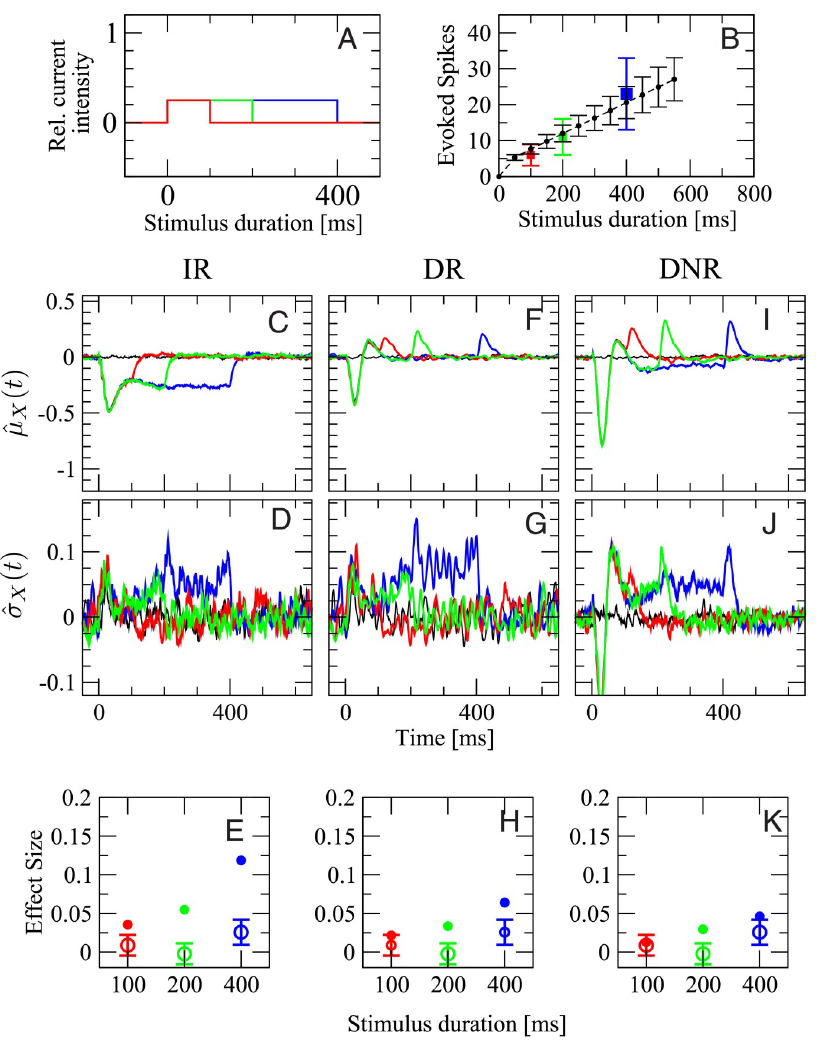
Fig 7. Experimental data for stimuli of equal intensity and different duration are compatible with simulation results from DR and DNR, but not from IR. A : stimulation currents used in this figure. The color coding (red: 100 ms, green: 200 ms, blue: 400 ms) applies to all panels. B : number of spikes evoked in the targeted neuron vs. stimulus duration in the model (black circles and dashed line) and in the experiments (squares colored as in A ). First row ( C,F, I ): deviation from the spontaneous value of the time-dependent mean readout activity normalized by the spontaneous standard deviation, defined in Eq (13). Second row ( D,G,J ): deviation from the spontaneous value of the time- dependent standard deviation of the readout activity normalized by the spontaneous standard deviation, defined in Eq (16). Third row ( E,H,K ): average effect size for the three stimuli in A . Open circles with error bars: experimental data (average over 119 RS cells and 2407 total trials); filled circles of corresponding color: model simulations. First column ( C,D,E ): IR. Second column ( F,G,H ): DR. Third column ( I,J,K ): DNR. Black line: catch trial